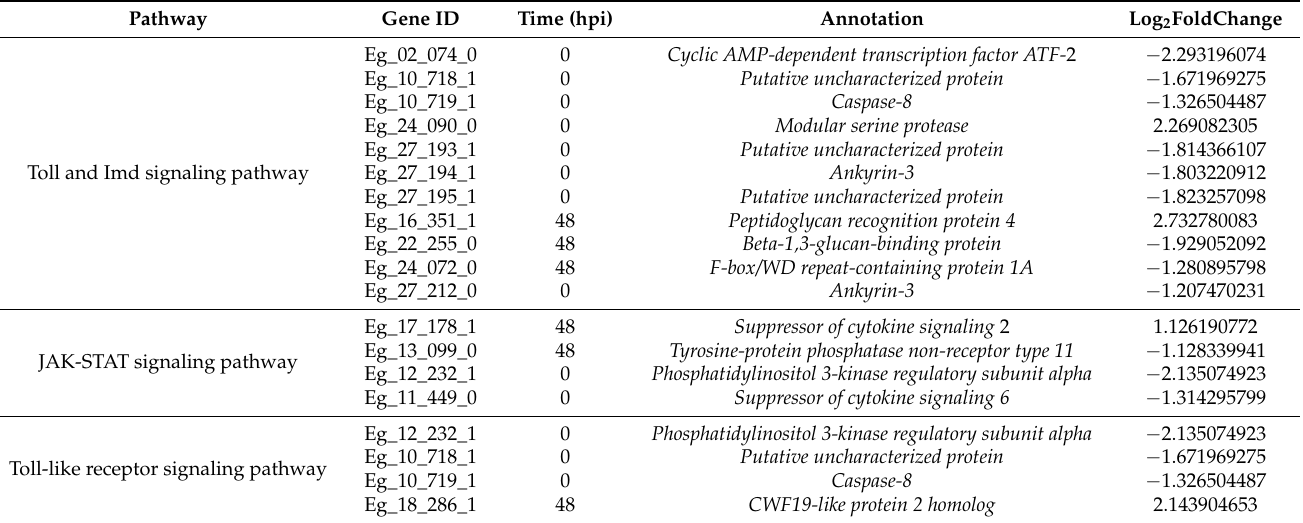
Table 3. Immune-related gene statistics of DEGs among different time-points after infection. The DEGs were analyzed, and the DEGs related to immunity in three common immune-pathways were